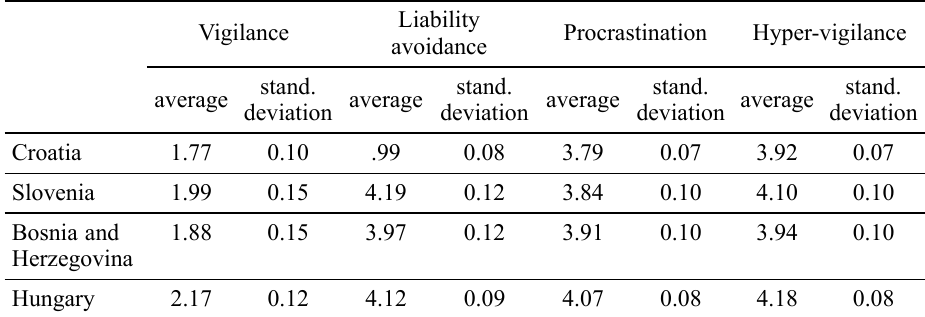
Table 8. Results on complex decision-making for Croatia, Slovenia, Bosnia and Herzegovina, Hungary Liability Vigilance Procrastination Hyper-vigilance avoidance stand. stand. stand. stand. average average average average deviation deviation deviation